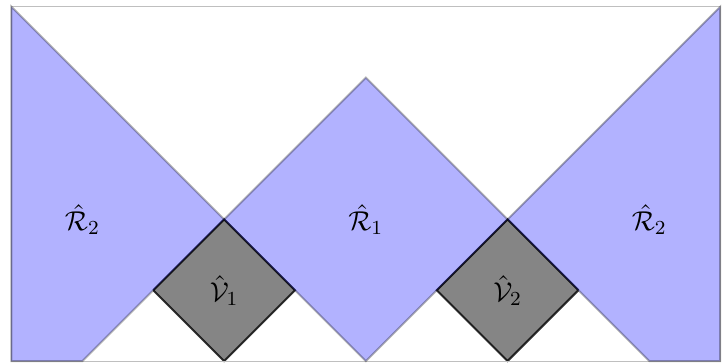
ˆ ˆ ˆ ˆ ˆ ˆ C 1 = V 1 , C 2 = V 2 , R 1 , R 2 in the boundary of Poincaré-AdS